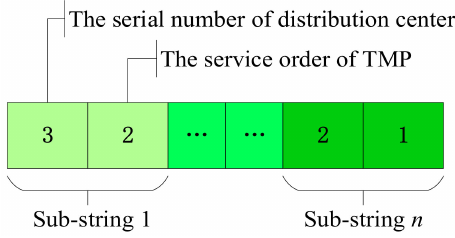
Figure 3. Example of chromosome